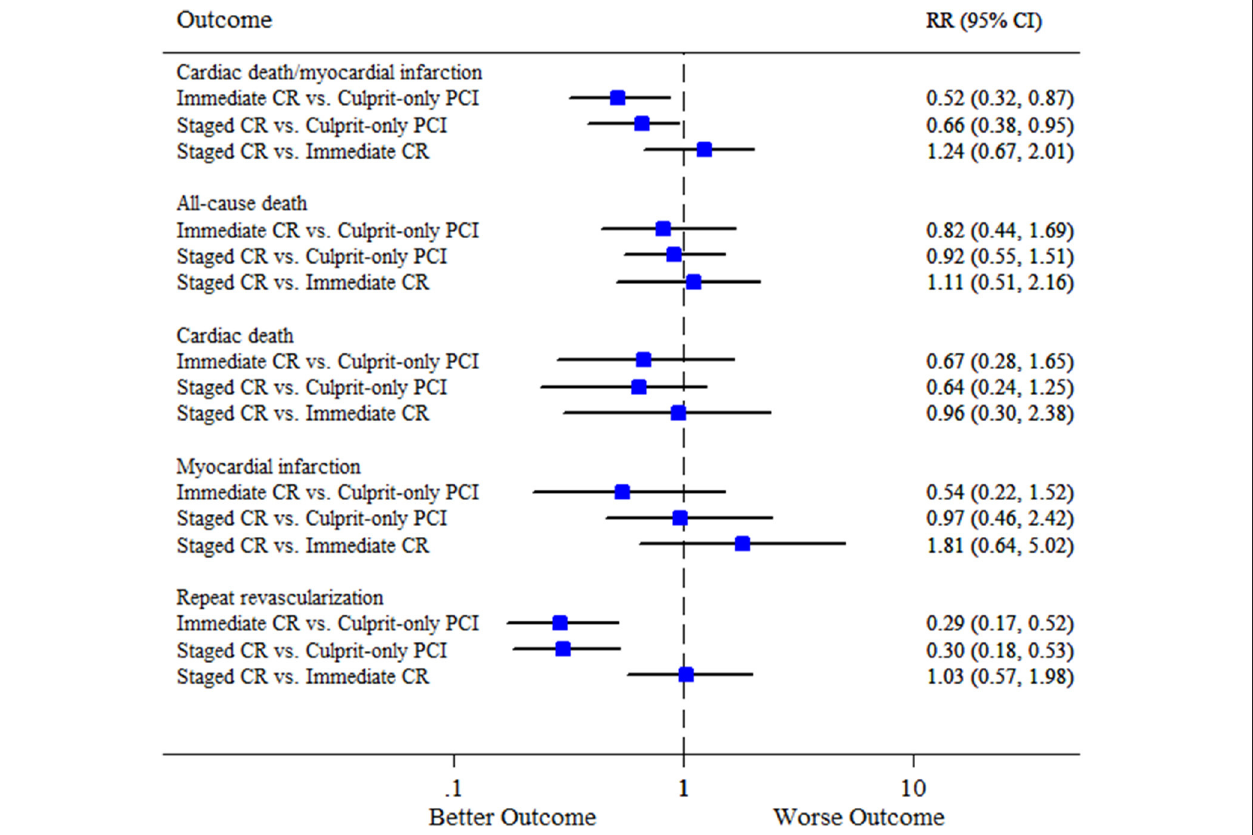
FIGURE 4 | Summary plot for the efficacy outcomes in network meta-analysis. CI, confidence interval; CR, complete revascularization; PCI, percutaneous coronary intervention; RR, relative